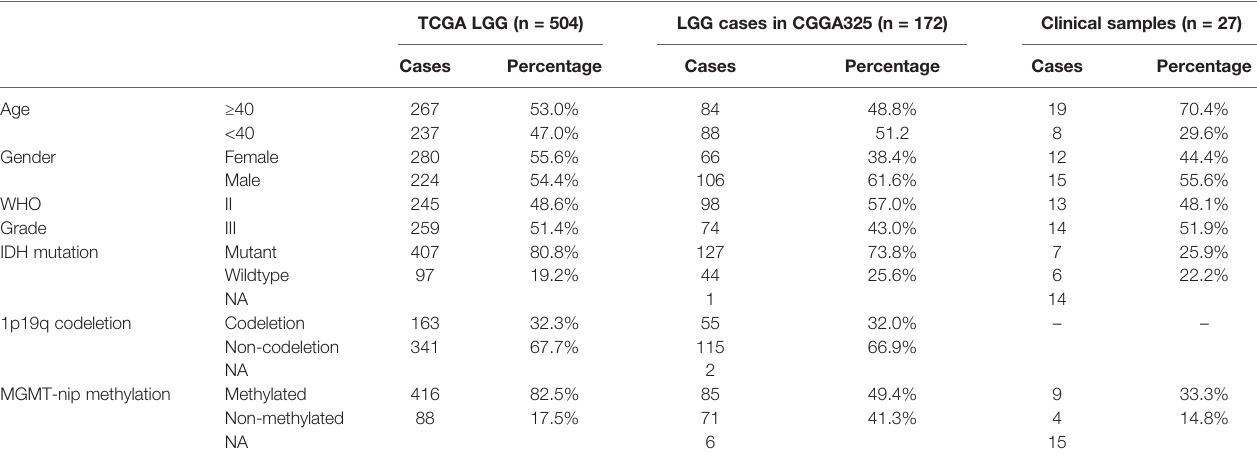
TABLE 1 | Clinical characteristics of cases in TCGA, CGGA and collected glioma samples.